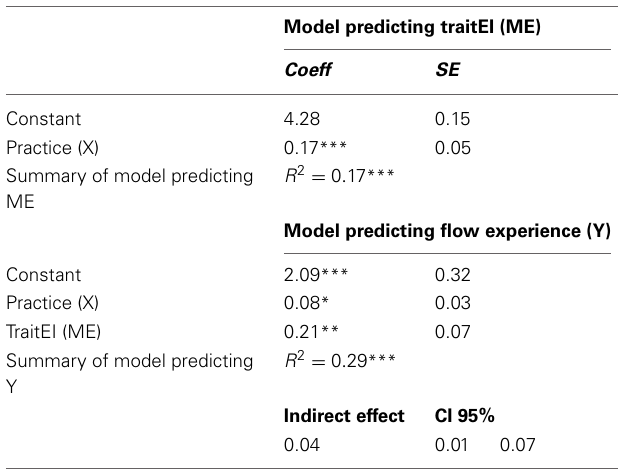
FIGURE 1 | Relationship between mean trait emotional intelligence scores, average amount of daily practice and mean dispositional flow scores in piano performance students ( N = 62).